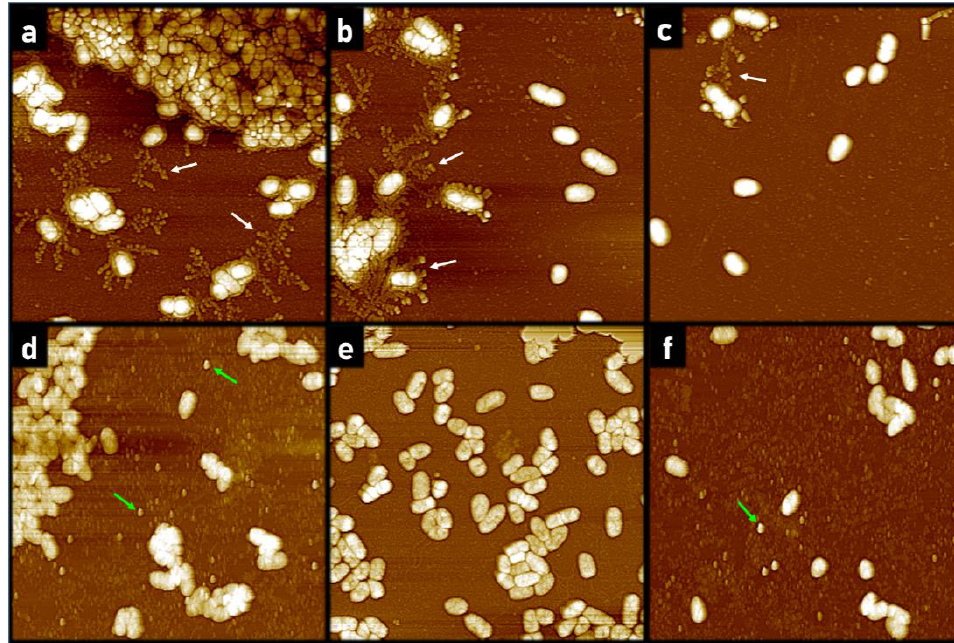
Figure 3. Representative 20 µm × 20 µm AFM images visualizing extracellular content surrounding individual bacteria. Bacteria were incubated for 18 h in the presence of CL-PL (125 µg/mL) ± HBD2 (0.25 µM) or solvent control. ( a – c ) Solvent control incubated bacteria, ( d ) CL-PL-treated, ( e ) HBD2- treated, and ( f ) CL-PL + HBD2-treated. White arrows highlight extracellular structures. The small, round structures (indicated by the green arrows) are consistent with liposomes. Images were first- order flattened. Images are representative of a total of 17 (CTRL, HBD2) or 30 (CL-PL, CL-PL + HBD2) scans per treatment, derived from two independent experiments.